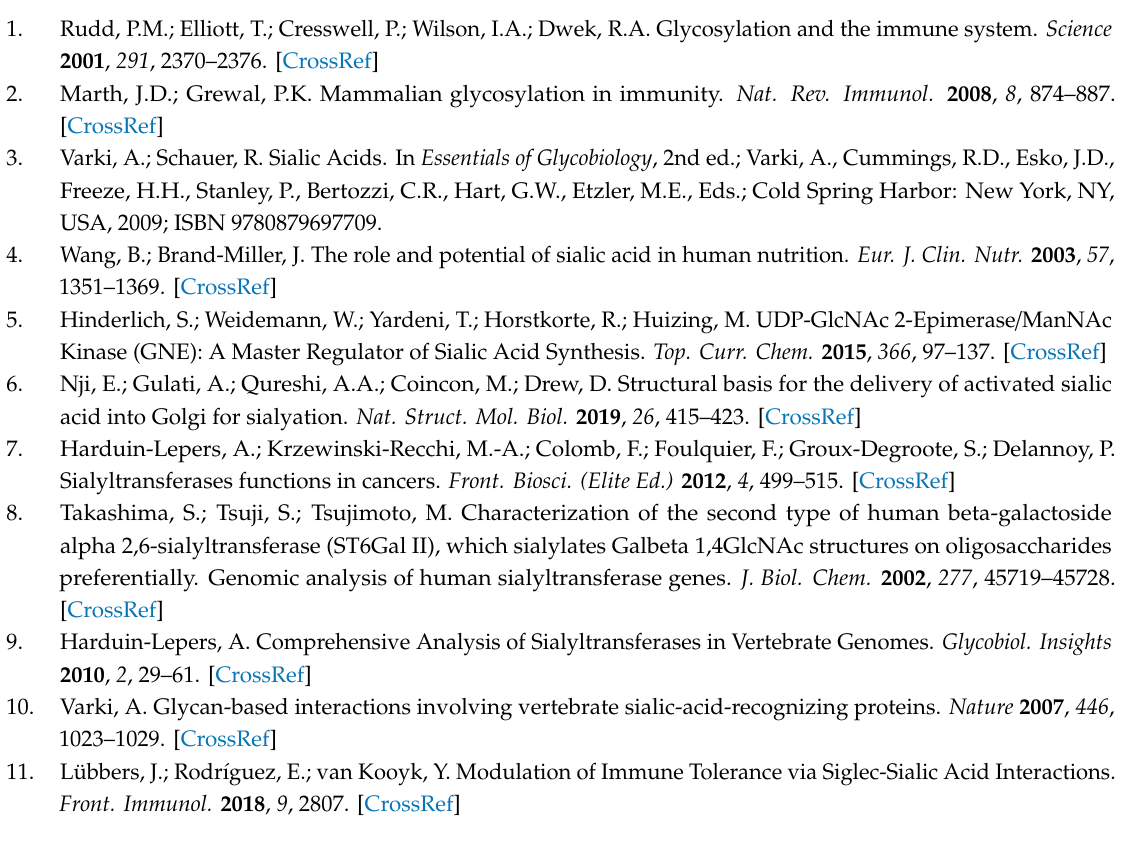
Table S1: Human sialyltransferases. Figure S1: Gating strategy for flow cytometry. Figure S2: Sialyltransferase expression in NK cells. Figure S3: Expression of IFN- γ in NK-92 cells after activation with IL-2. Author Contributions: Conceptualization, P.R. and R.H.; formal analysis, P.R.; investigation, P.R. and